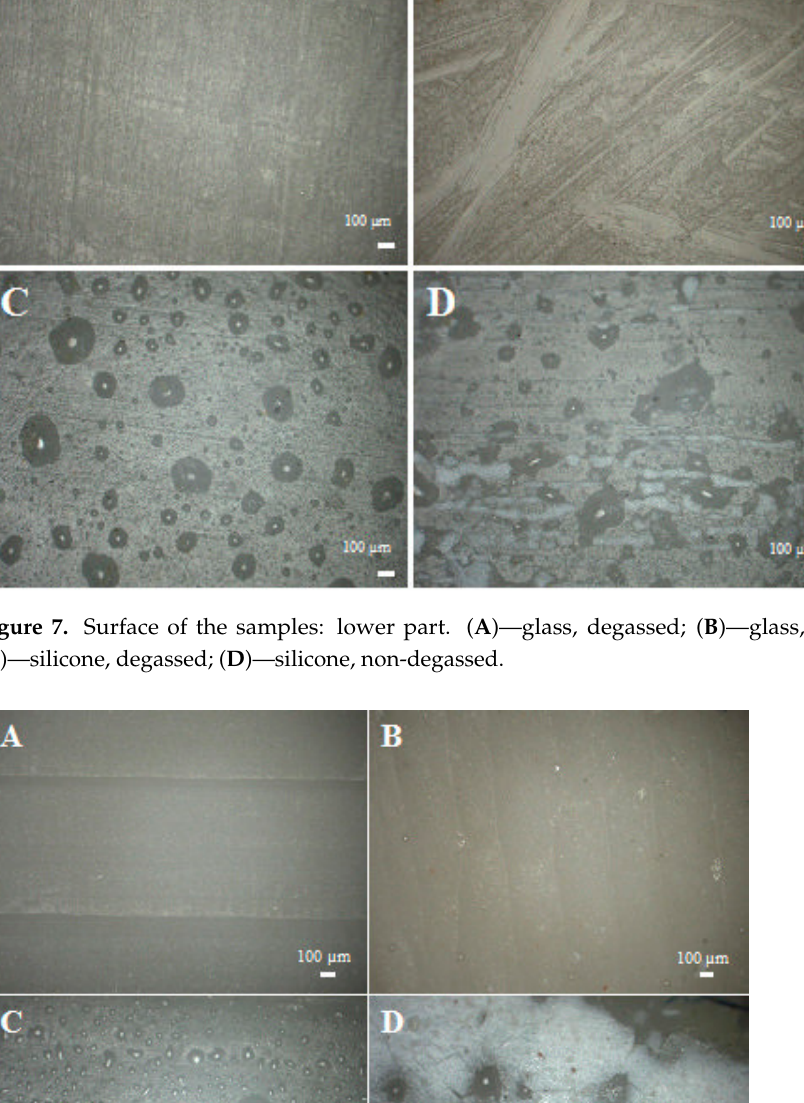
Figure 9. Photos of side edges of the samples, ( A )—glass, degassed; ( B )—glass, non-degassed; ( C )— silicone, degassed; ( D )—silicone, non-degassed.